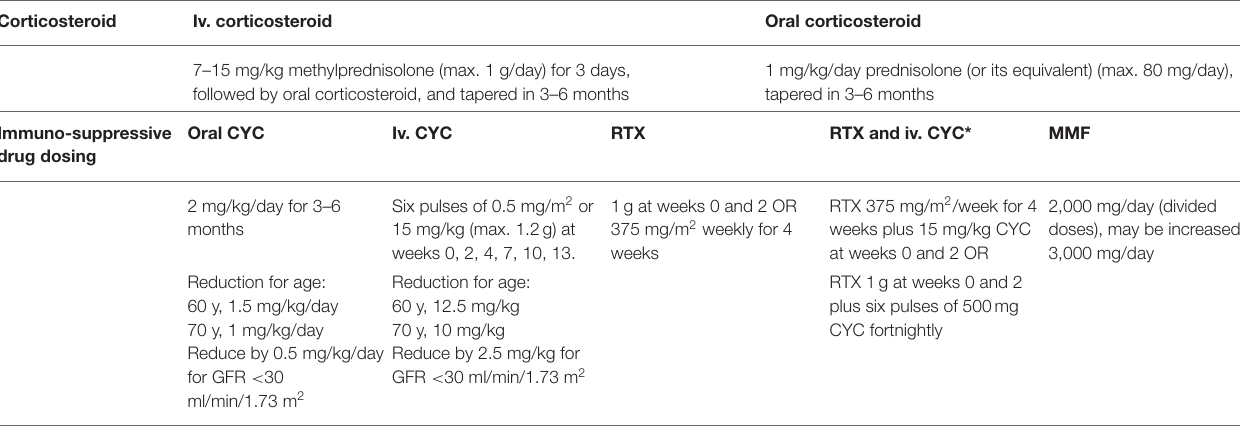
TABLE 2 | Remission induction therapy in ANCA-associated glomerulonephritis according to the KDIGO 2021 Clinical Practice Guideline for the Management of Glomerular Diseases (43). Corticosteroid Iv.